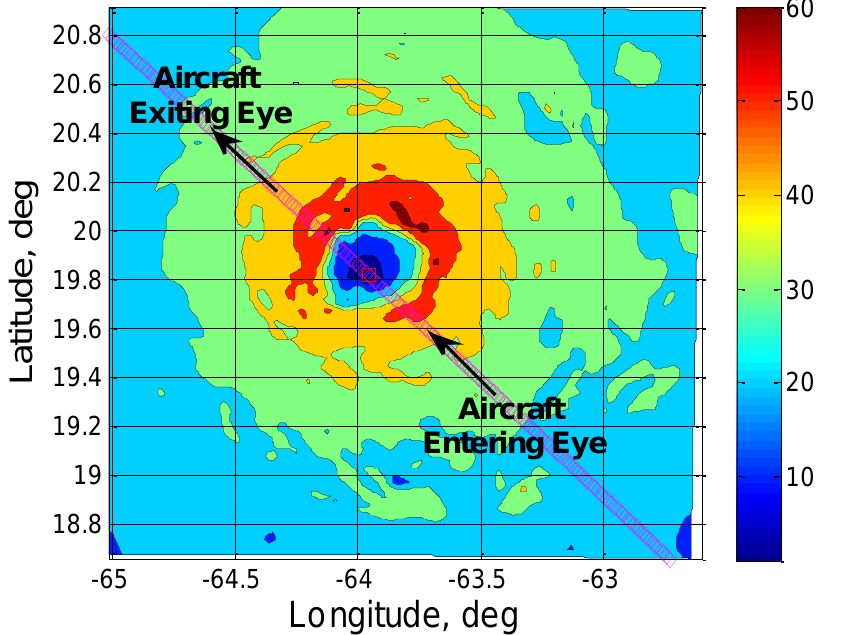
Figure 1. Hurricane Frances wind field on 31 August, 2004 with wind speed (m/s) represented by the filled-contours colorscale. The aircraft ground track is shown as the solid (magenta)